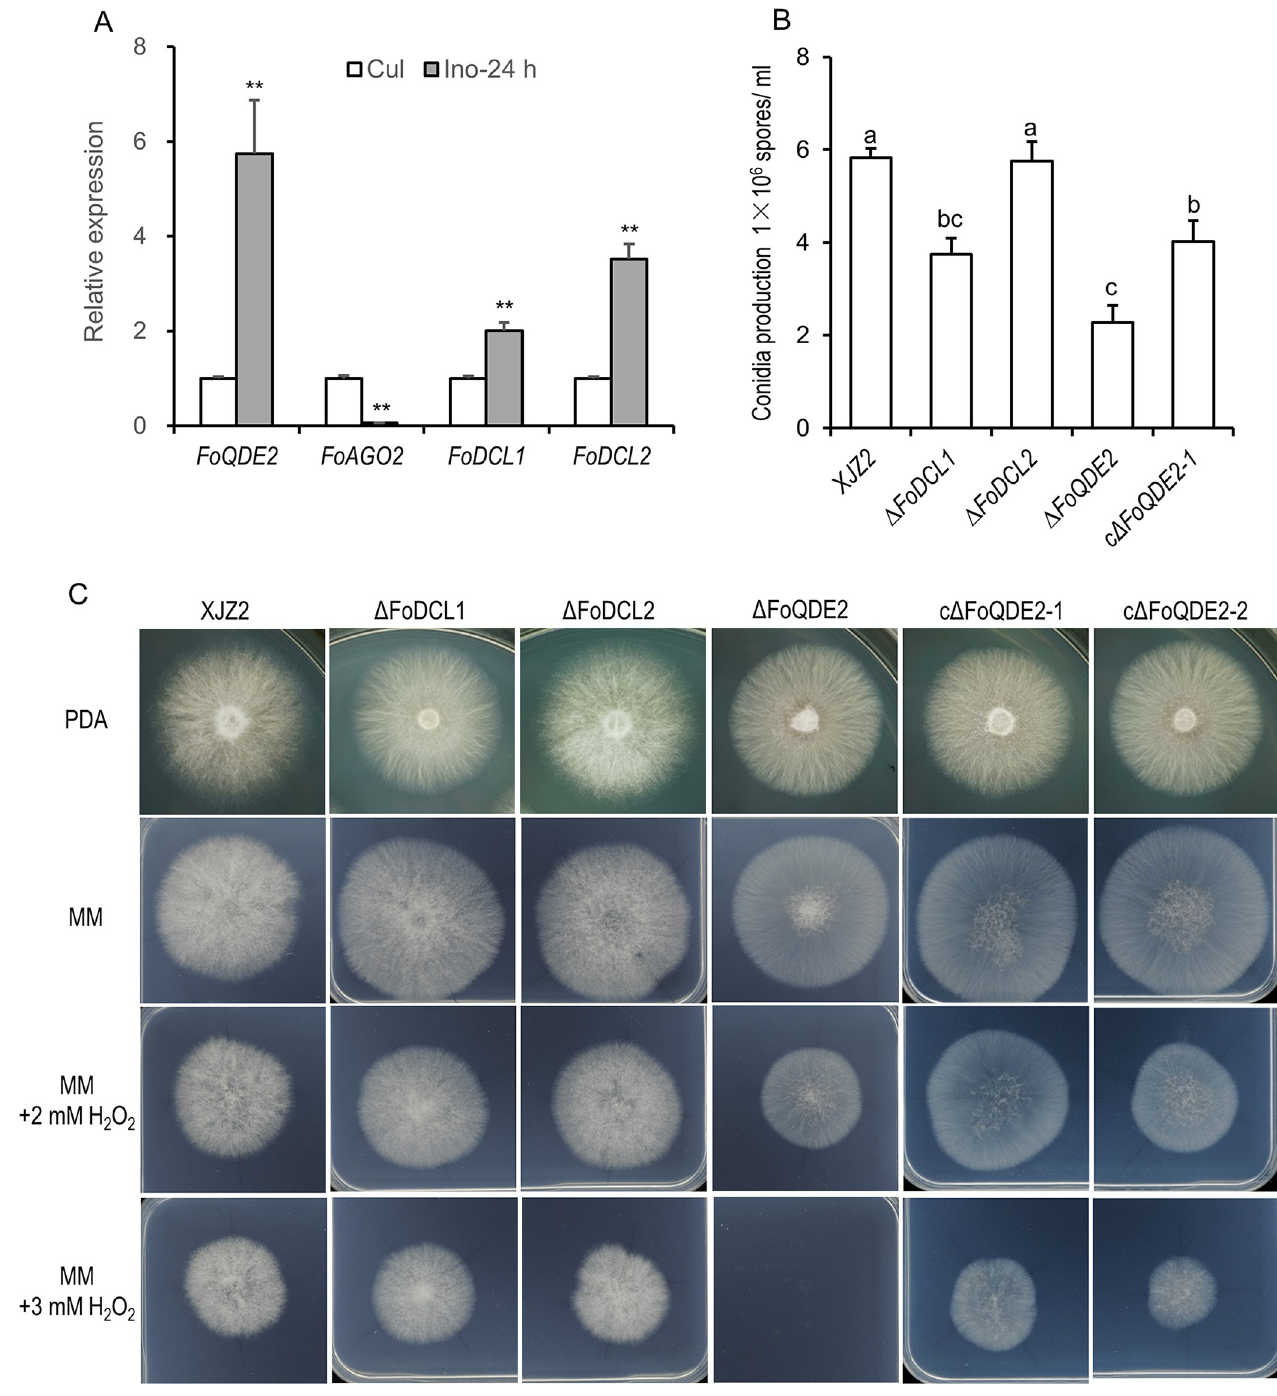
Fig 2. Characterization of milRNA biosynthetic pathway genes in F . oxysporum f. sp. cubense . ( A ) Expression patterns of milRNA biosynthetic pathway genes at pure culture conditions (Cul) and 24 hours post inoculation (Ino-24h). Relative folds were calculated by 2 - ΔΔ Ct method [56], using transcription elongation factor 1 α gene ( EF1 α ) as internal control. Error bars indicate S.D. (n = 3). A Student’s t -test was used for significant analysis. �� , p < 0.01. ( B ) Conidial production of the tested strains. The tested strains were grown on PDA plates at 28˚C for 7 days. Then same amounts of colony discs were washed by water supplemented with 0.05% tween 20 to prepare conidia suspension. And conidia were quantified under microscope using a haemocytometer. A Duncan’s multiple range test was used for significant analysis. Error bars indicate S. D. (n = 10). Different letters indicate significant difference at the level of α = 0.01. ( C ) Colony morphology of the tested strains grown on PDA, minimal medium (MM), MM supplemented with 2 or 3 mM H 2 O 2 . The wild-type strain XJZ2, milRNA biosynthetic pathway gene knockout mutants ( Δ FoQDE2 , Δ FoDCL1 , and Δ FoDCL2 ), and two FoQDE2 complementation transformants (c Δ FoQDE2 -